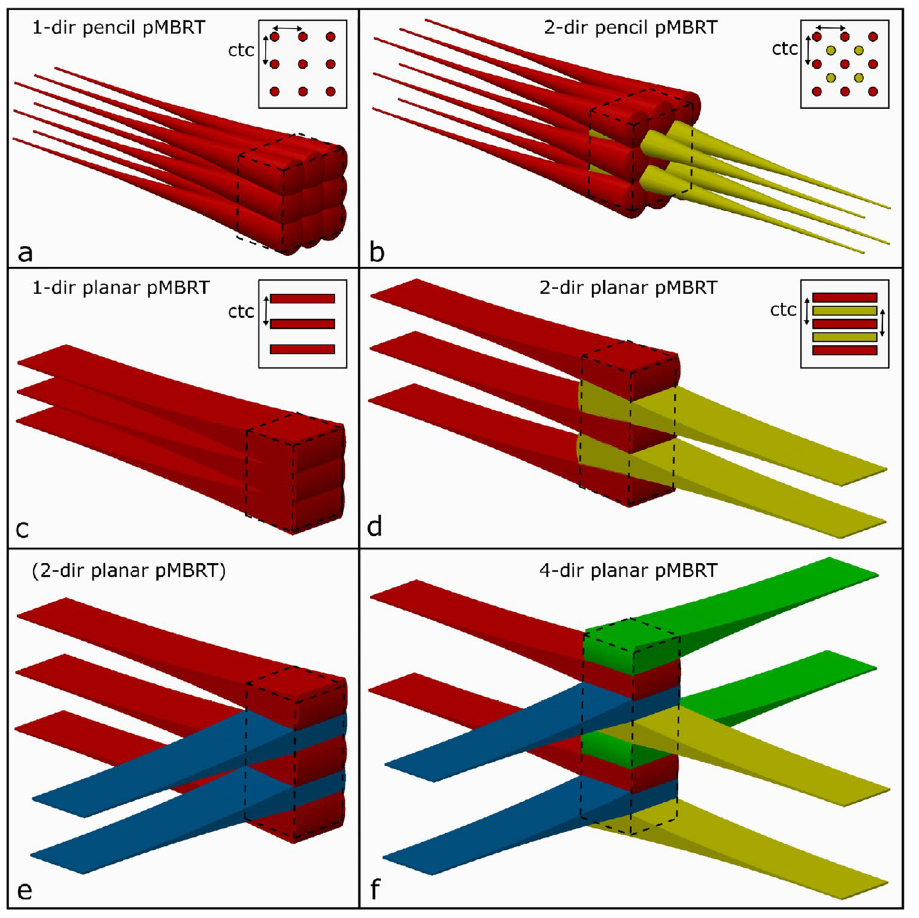
Figure 1. Schematic representation of unidirectional proton minibeams and interlaced minibeams from multiple directions. Unidirectional minibeams can be applied with pencil ( a ) or planar ( c ) minibeams. Pencil minibeams are interlaced from two opposite directions ( b ) with the two grids shifted by (ctc/2, ctc/2). Planar minibeams are interlaced from two opposing ( d ) and two orthogonal ( e ) directions with the two grids shifted by (ctc/2). Planar minibeams are also interlaced from four directions ( f ; 90° between all neighboring directions, grids shifted by ctc/4 between neighboring directions). Figures are created using the Creo 2.0 software. Credit: Peter